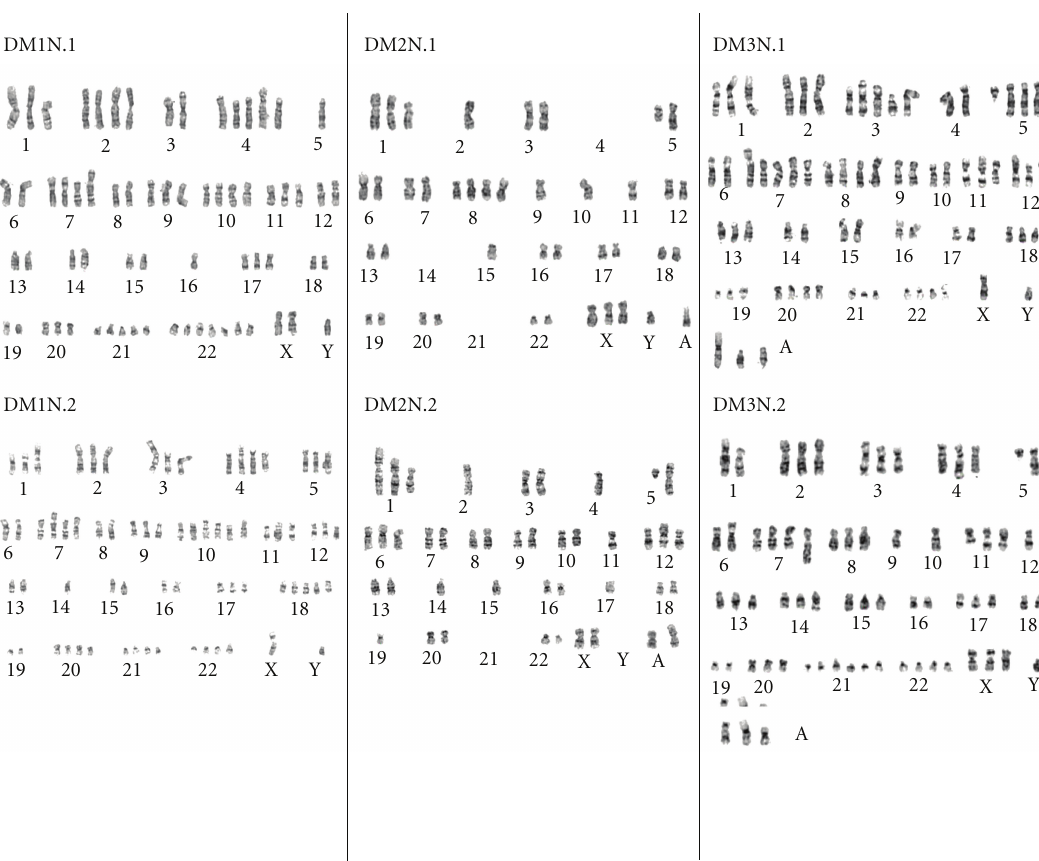
Figure 1: Chromosomal abnormalities are prevalent in melanoma. Shown are pairs of representative karyotypes from 3 melanoma lines, DM1N, DM2N, and DM3N revealing heterogeneity between cells within the culture and overall increases (D1 and D3) and decreases in the total number of chromosomes (D2). Single cell clones from these lines will also expand in culture giving rise to cells with di ff erent karyotypes (data not shown) suggesting ongoing